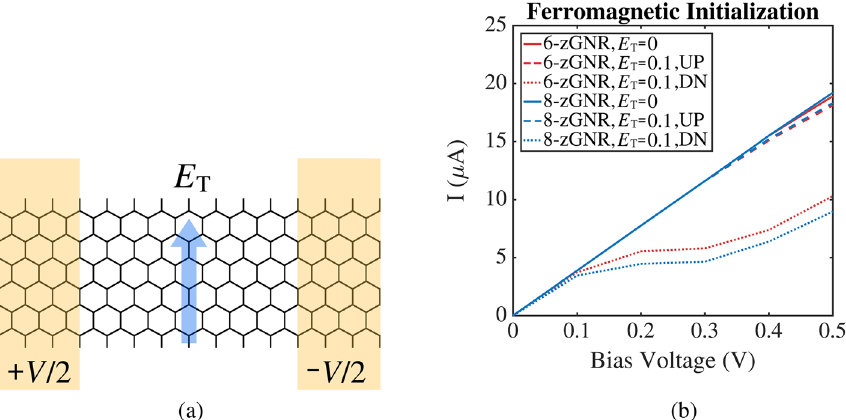
Figure 1. Schematic diagram of a 6-zGNR subjected to a bias voltage and a transverse electric field (left). Total current (solid lines) versus bias voltage for 6 and 8-zGNR at zero transverse electric field strength and spin currents (dotted lines) versus bias voltage for 6-zGNR and 8-zGNR at a transverse electric field strength of 0.1V / Å